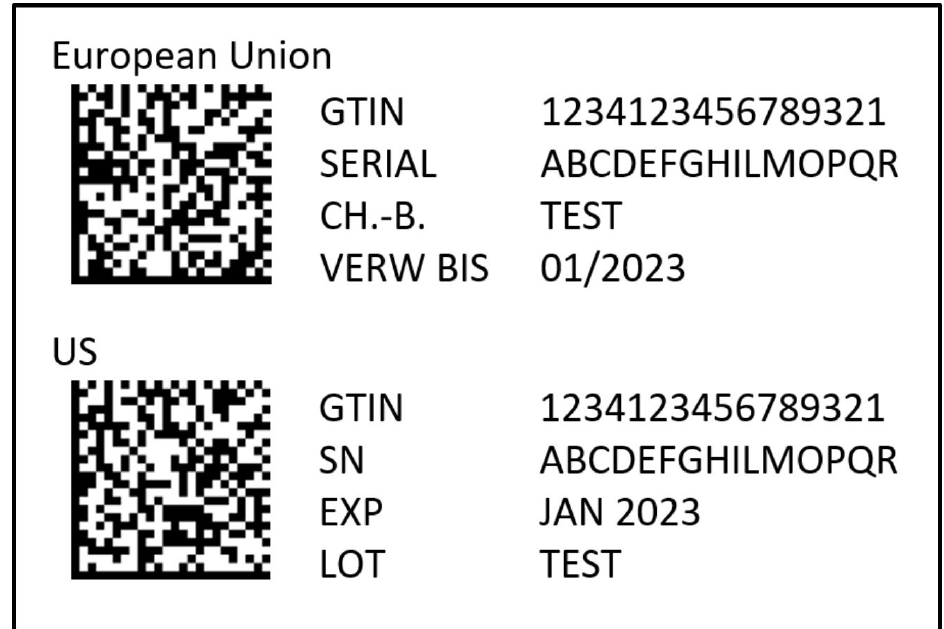
Figure 3. GS1 QR codes for the serialization standard in Europe and the